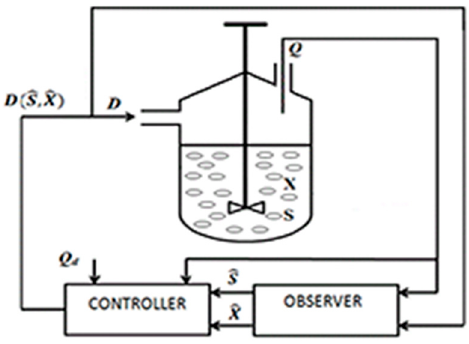
Figure 4. Control based on observer state estimation.